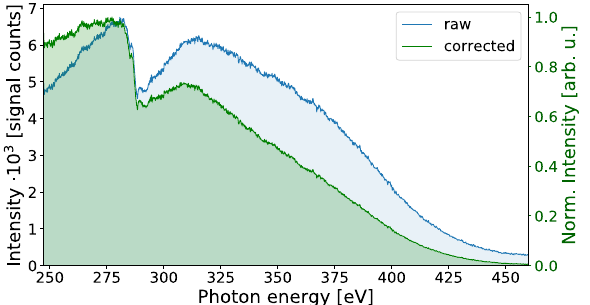
Figure 2. Typical measured raw (blue curve) and Jacobi-corrected (green curve) SXR spectrum generated in helium and transmitted through 150 nm Al filter. The integration time was set to 0.5 s and the camera gain to two. The absorption peak around 285 eV is due to carbon contamination of the SXR